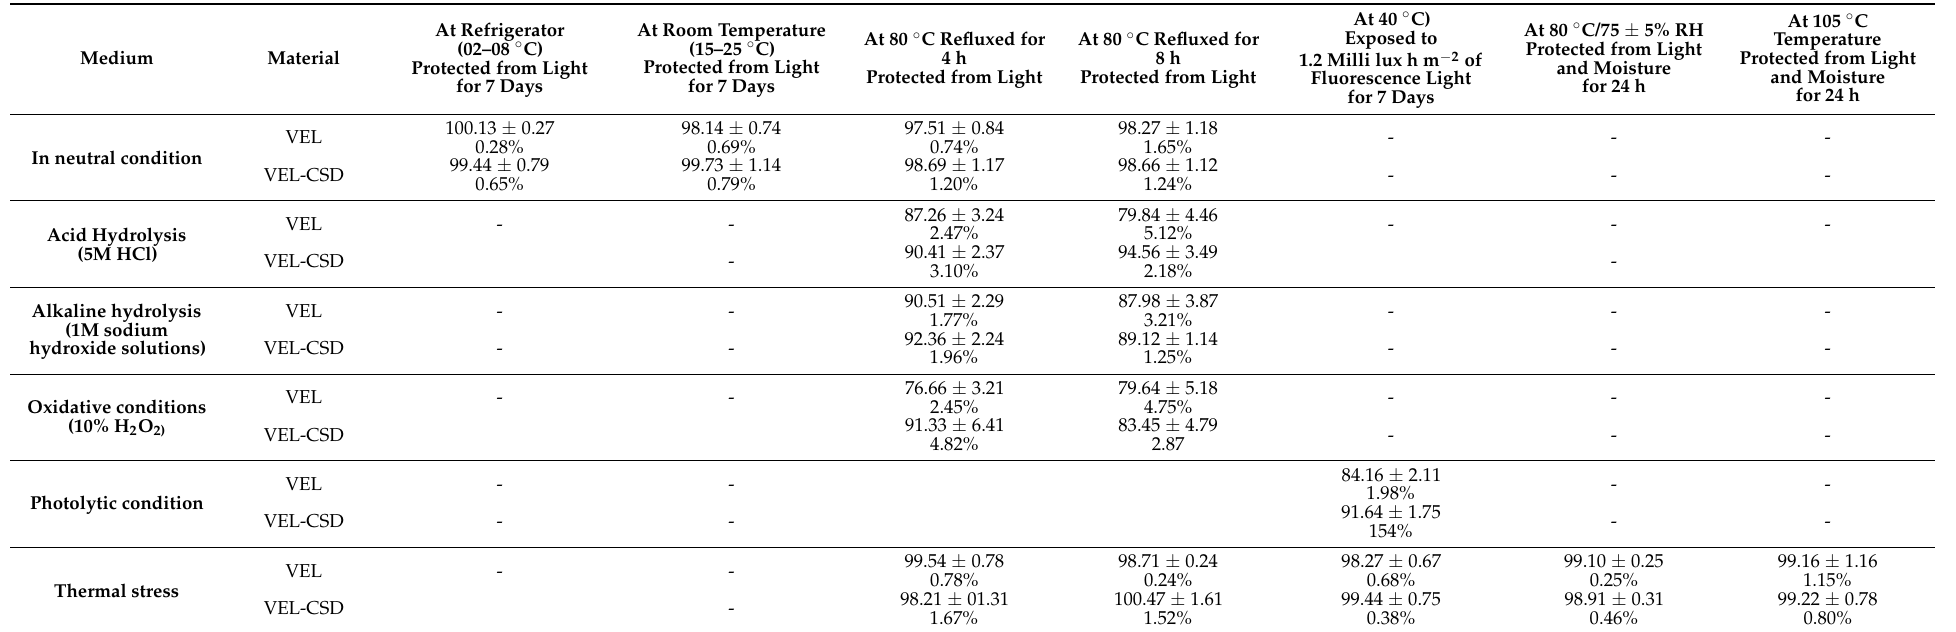
Table 4. Assay of VEL and VEL-CSD after exposure to stressed